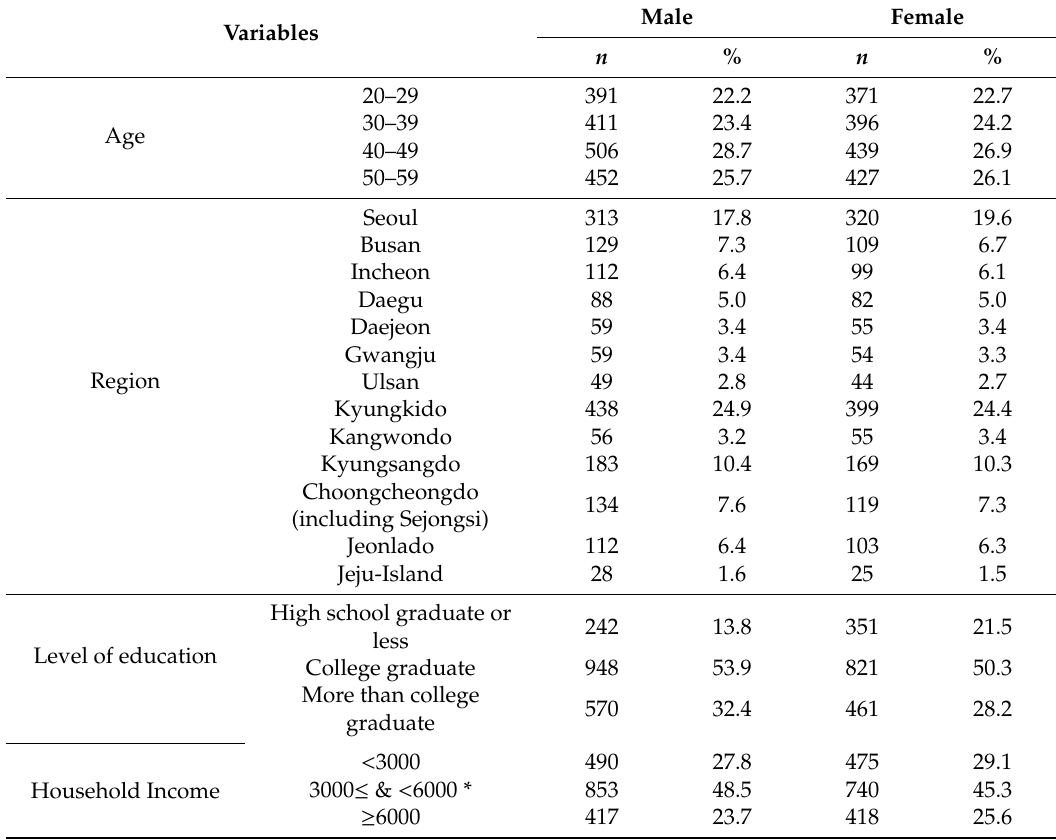
Table 1. Socio-demographic characteristics of the study subjects (Male = 1760, Female =